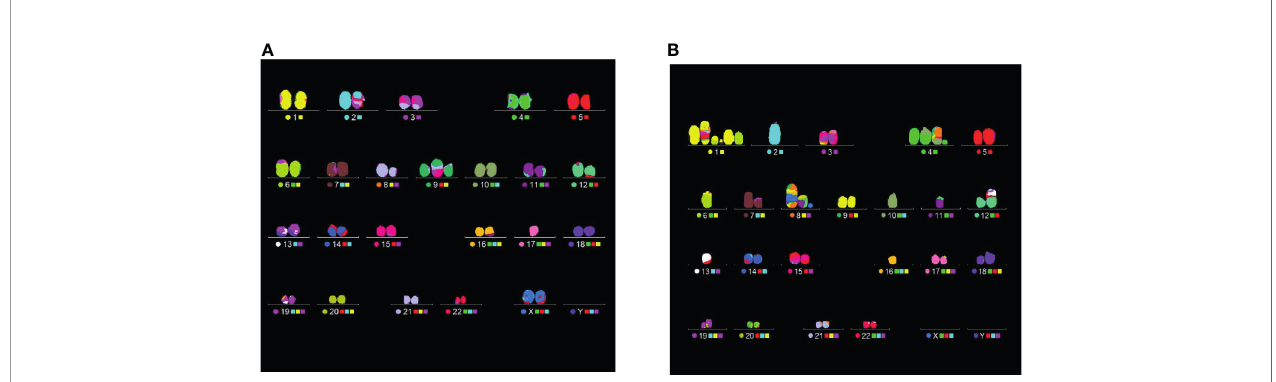
FIGURE 11 | Examples of CA analysis by mFISH. Images depict karyotypes from samples irradiated at the CNAO beamline with 4 Gy of protons in the presence of BSH and show typical aberrations types found at two positions, i.e. a simple exchange between chromosomes 2 and 17 from a cell exposed at the entrance [left panel, (A) ] and several complex rearrangement detected in a PCC spread from a cell irradiated at the distal position [right panel, (B) ]. See main text